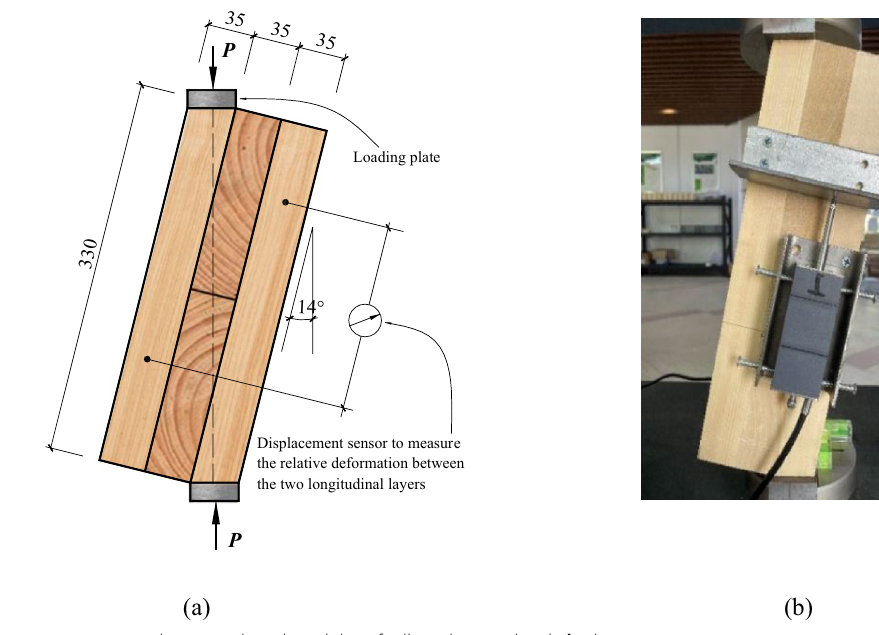
Fig. 3 Test setup to measure the strength and modulus of rolling shear: a sketch; b